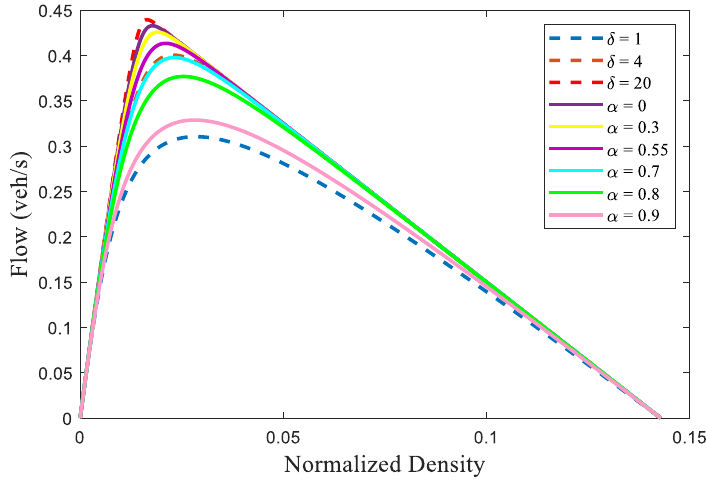
Figure 2. Flow for the ID and proposed models over an 800 m circular road for different acceleration exponents and weather severity indices, respectively.